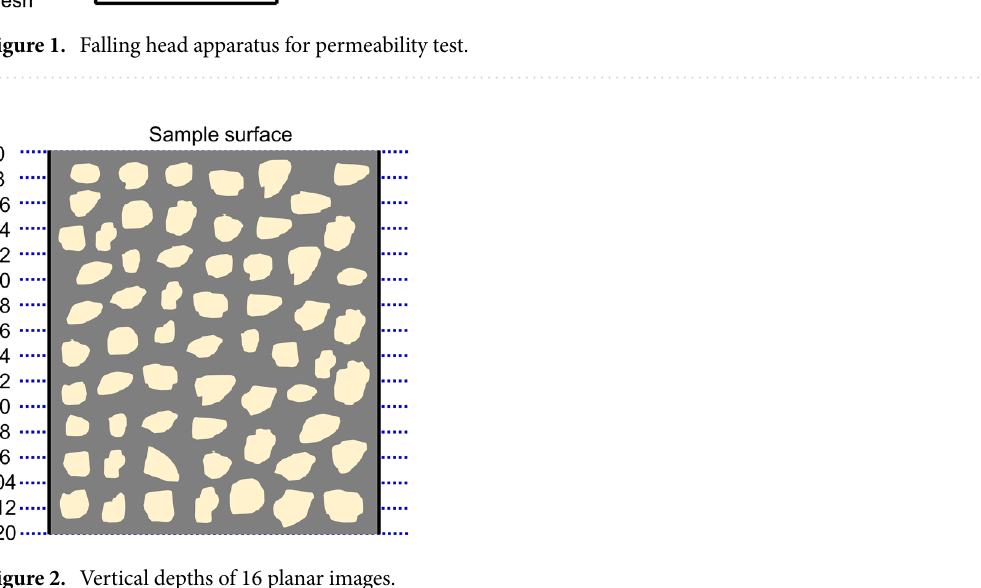
Figure 2. Vertical depths of 16 planar